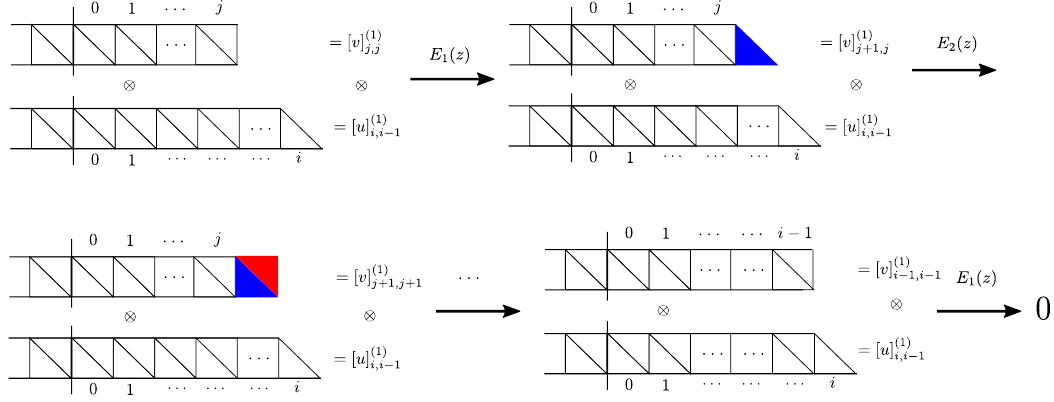
Figure 22. Sequence of actions of E 1 ( z ) and E 2 ( z ) on the second tensor components of [ u ] (1) and [ u ] (1) ⊗ [ v ] (1) i,i − 1 j,j − 1